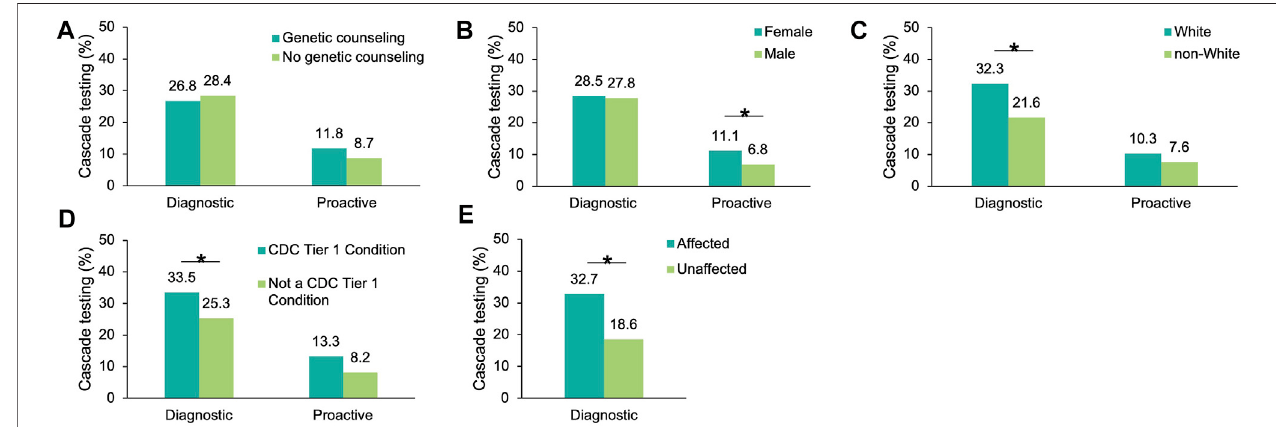
FIGURE3| Factorsin fl uencing cascade testing amongprobandswithapositiveresult inanHCS gene.Cascadetesting rateswerecalculatedforprobands witha positive fi nding in an HCS gene and strati fi ed by proband characteristic: (A) Whether the proband had genetic counseling through Invitae, (B) Sex (C) Self-reported ancestry, (D) Whetherthepositive fi ndingintheprobandwasinageneassociatedwithaCDCTier1condition,and (E) Whetherdiagnosticprobandsreportedafamilyor personal history of cancer (this information was not available for proactive probands). HCS, hereditary cancer syndrome.